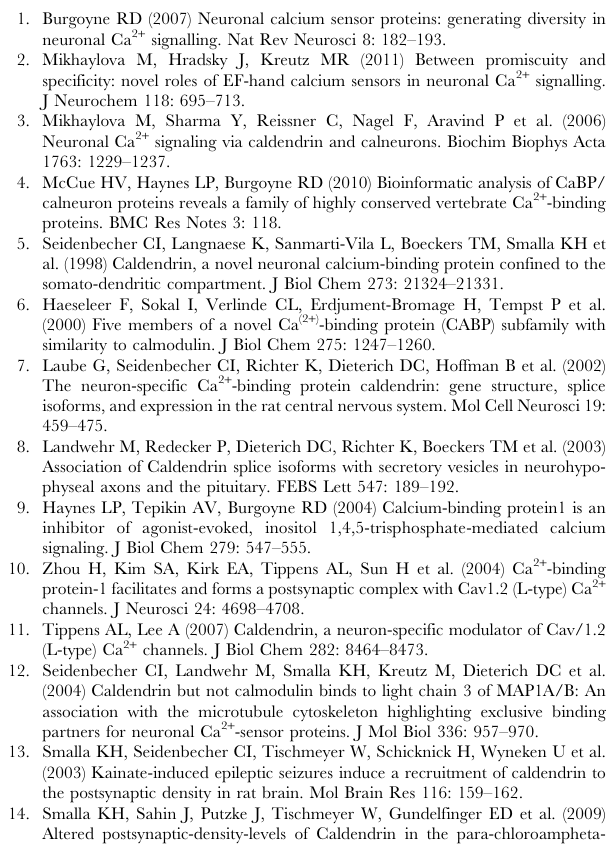
Figure S3 Size exclusion chromatography. (A) Overlaid gel filtration chromatograms of Caldendrin injected in the presence of Mg 2 + (500 m M Mg 2 + red 200 m M EGTA; red) or Mg 2 + + Ca 2 + (500 m M Mg 2 + /100 m M Ca 2 + ; black). Chromato- grams of Caldendrin were compared with low molecular weight calibration kit proteins (GE Healthcare/green). The first peak (10– 11 elution volume in ml) eluted at the size of the dimer and the second peak (11.5–12 ml) eluted at the size of the monomer. Absorption of all chromatograms was done at the wavelength 214 and 280 nm and with the 500 m l fractions size. (B) The chromatogram shows that recombinant Caldendrin elutes at the size of a monomer (11–11.5 ml) in the presence of 0.02% sodium dodecyl sulfate (SDS/black). A Caldendrin dimer was prominent when we incubated the protein with 0.01% Glutaraldehyde (GA) (red). Chromatograms of Caldendrin were compared with low molecular weight calibration kit proteins (GE Healthcare/green).